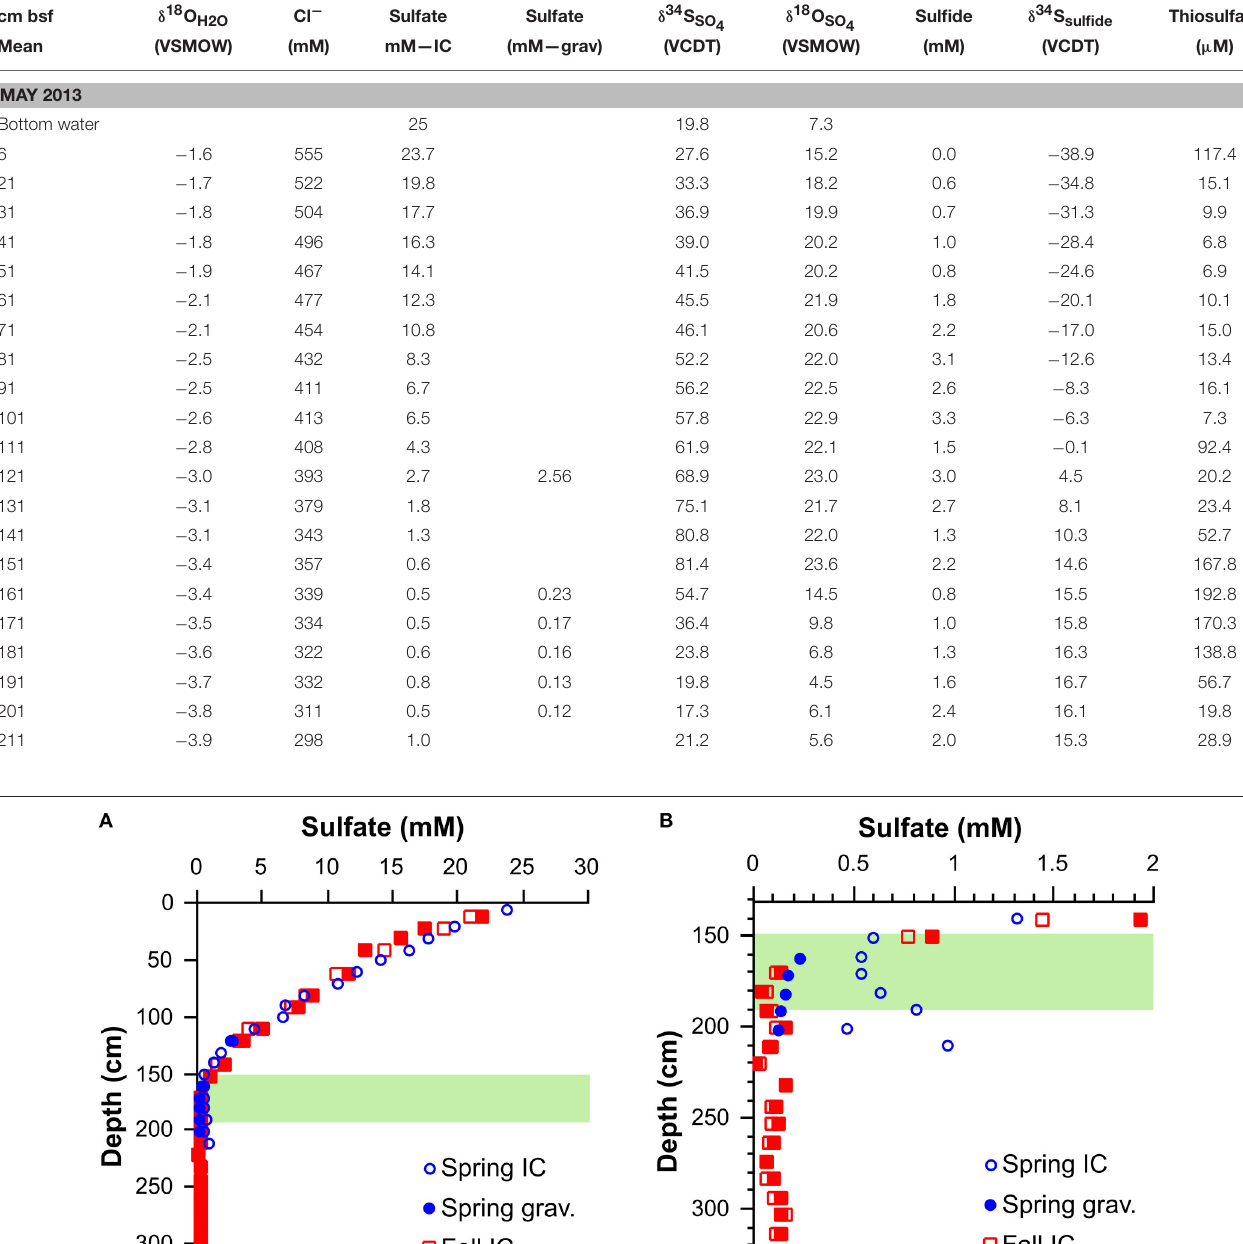
TABLE 2 | Concentration and isotope data for the Spring campaign.